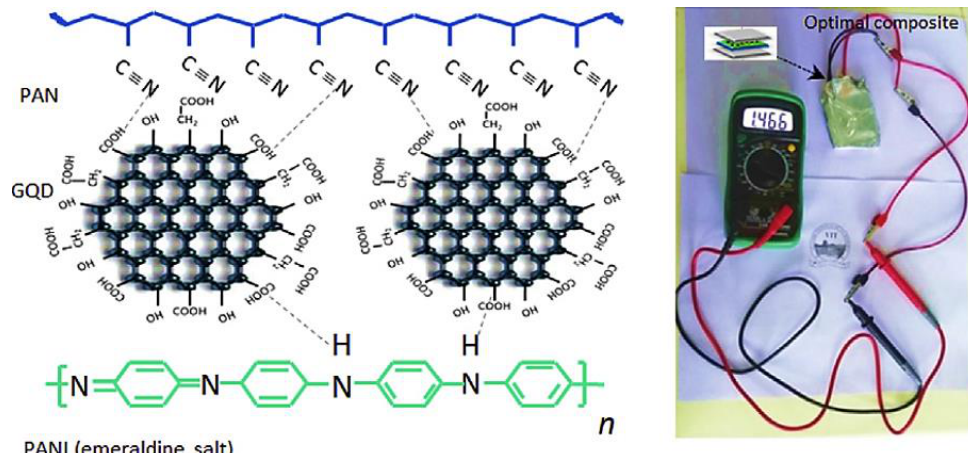
Figure 3. A green nanocomposite based on polyaniline (PANI), polyacrylonitrile (PAN), and a green graphene quantum dot (GQD) [85]. Reproduced with permission from Elsevier.